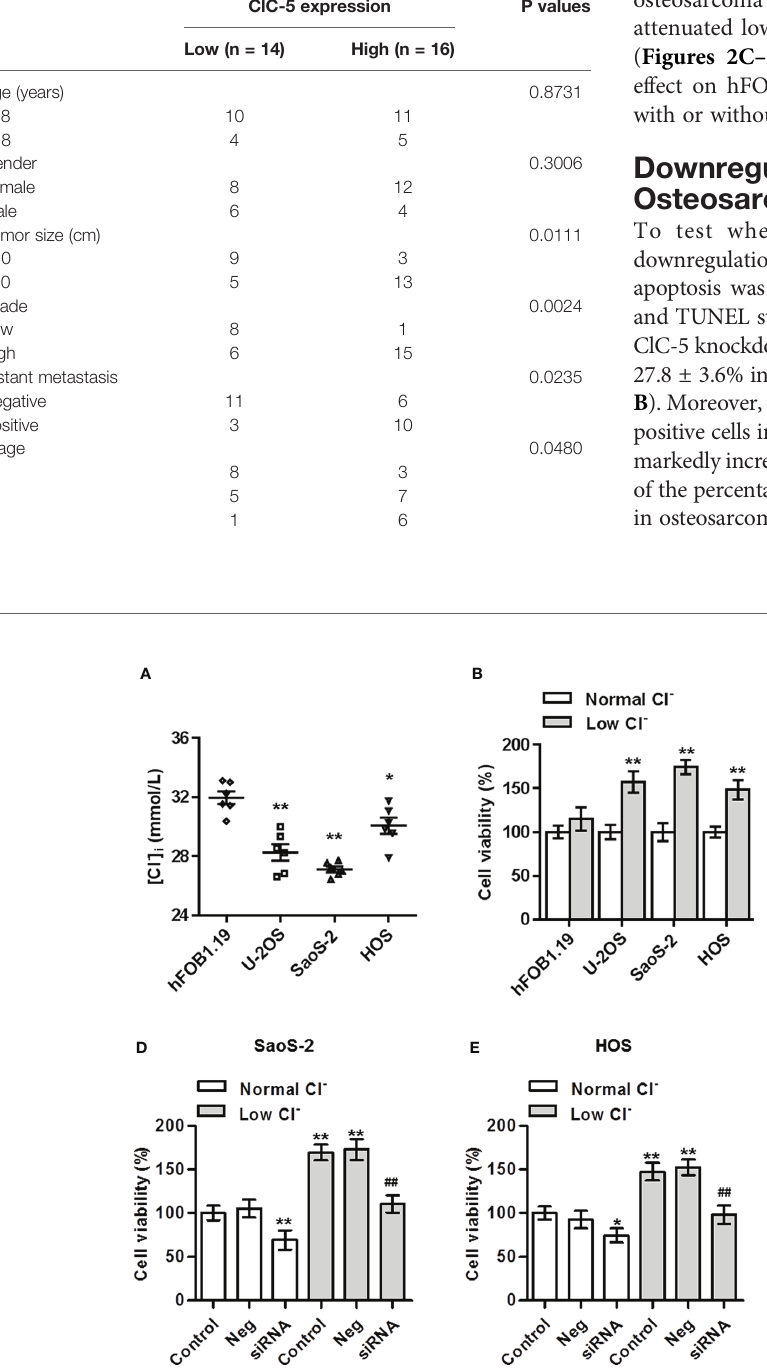
FIGURE 2 | Inhibition of ClC-5 attenuates low Cl − -induced the increase in osteosarcoma cell viability. (A) The intracellular chloride concentration ([Cl − ] i ) in hFOB1.19, U-2OS, SaoS-2, and HOS cells was examined using MEQ fl uorescence probe. *P < 0.05, **P < 0.01 vs. hFOB1.19 cells, n = 6. (B) hFOB1.19, U-2OS, SaoS-2, and HOS cells were incubated in normal medium or low Cl − medium for 24 h. Cell viability was assessed by CCK-8 assay. **P < 0.01 vs. normal Cl − , respectively, n = 6. (C – F) U-2OS (C) , SaoS-2 (D) , HOS (E) , and hFOB1.19 (F) cells were transfected with ClC-5 siRNA or negative siRNA (Neg) for 48 h and then treated with low Cl − medium for 24 h. Cell viability was determined. **P < 0.01 vs. normal Cl − +control; ## P < 0.01 vs. low Cl − +control, n =